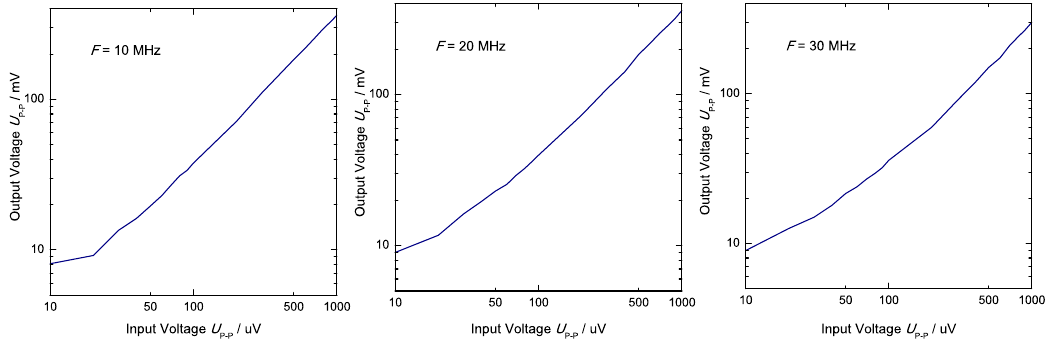
Figure 10. Experimental amplitude characteristics of the analog signal chain based on the gated amplifier. Table 1. Comparison of spectrometer parameters with the parameters of other commercial spectrometers.